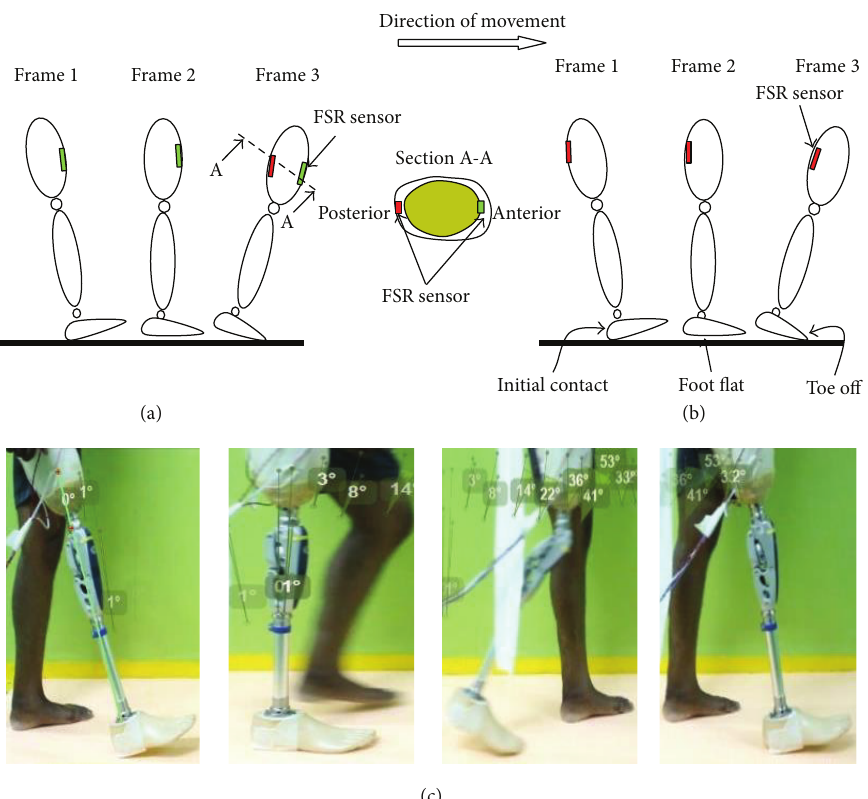
Figure 4: (a) Anterior FSR placement during full stance phase; (b) posterior FSR placement during full stance phase; and (c) the individual performing full stance phase (heel strike, flat foot, and toe off) while wearing the FSR instrumented